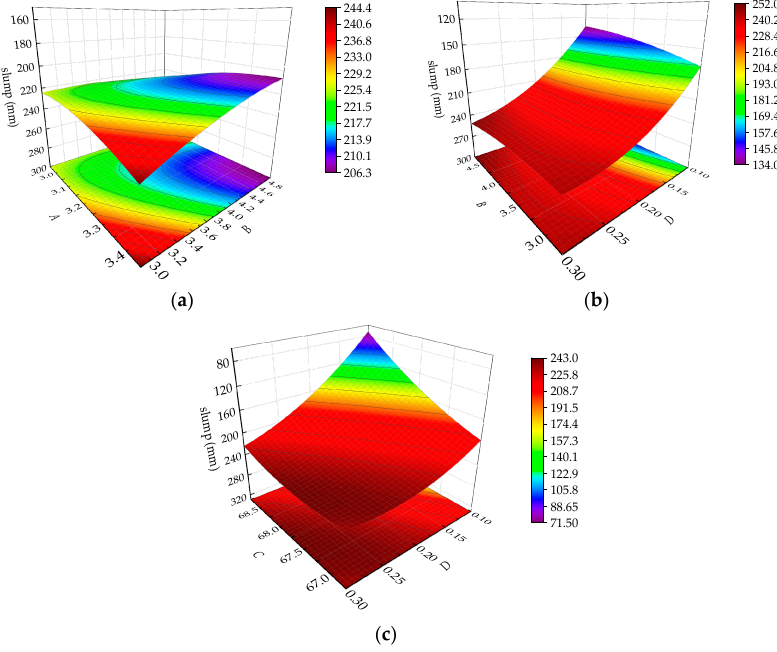
Figure 4. Interaction response surface diagram of various factors on the slump: ( a ) Interaction response surface diagram of AB on the slump, ( b ) interaction response surface diagram of BD on the slump, and ( c ) interaction response surface diagram of CD on the slump.